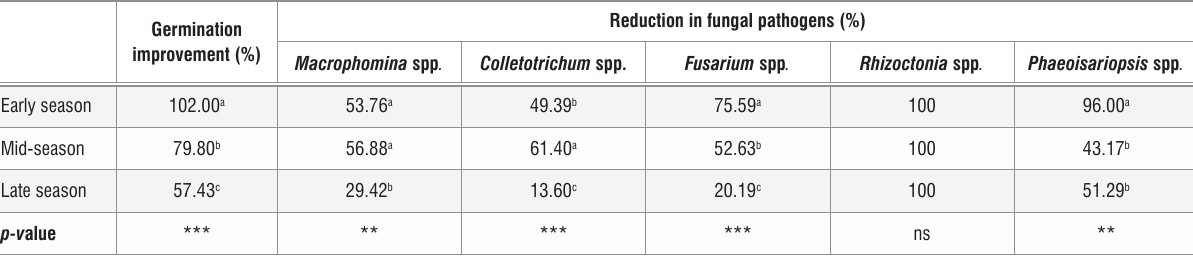
Spearman rank correlation matrix for relationships between normal germination and seed-borne fungi in unsorted, non-discoloured and dis- coloured seed Normal germination Unsorted seed Non-discoloured seed Discoloured seed Colletotrichum spp . -0.856*** -0.053ns -0.414** Phaeoisariopsis spp. -0.014ns -0.597** Macrophomina spp .